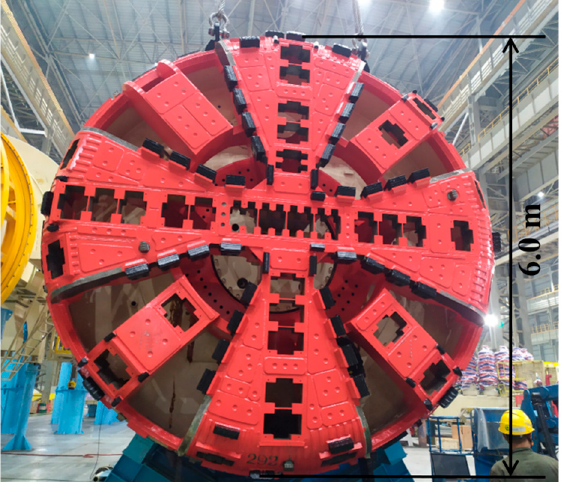
Figure 2. Involved soils of the tunnel construction at the Beijing south-to-north water diversion auxiliary project.